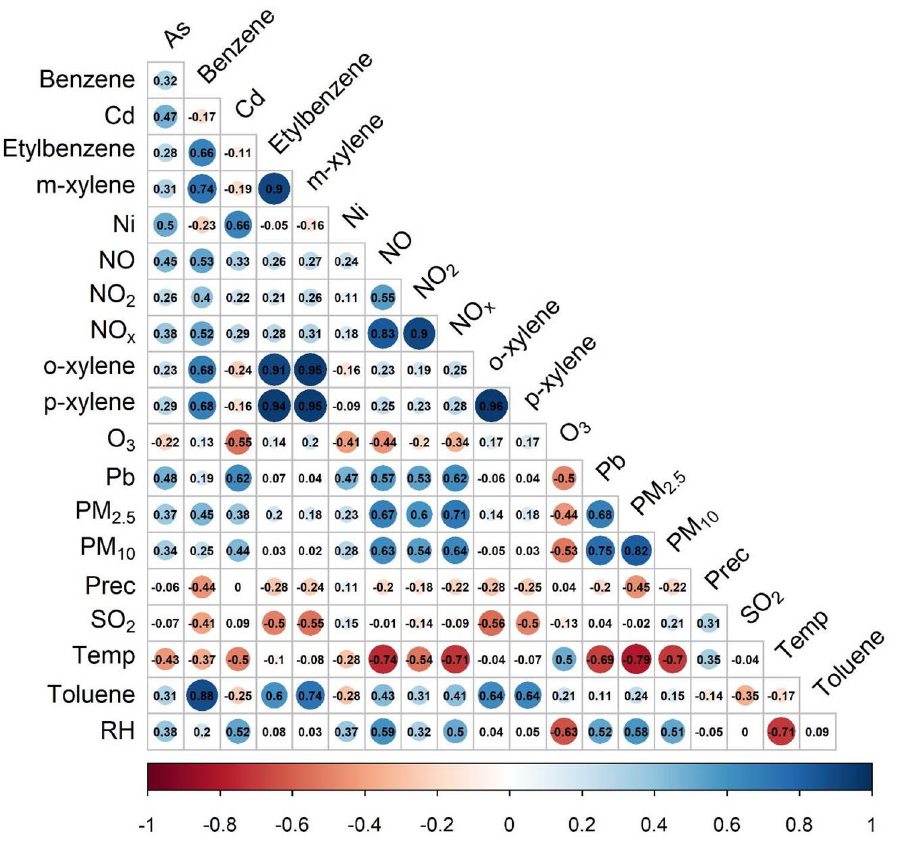
Figure 4. Spearman correlation coefficients between the studied air pollutants and environmental